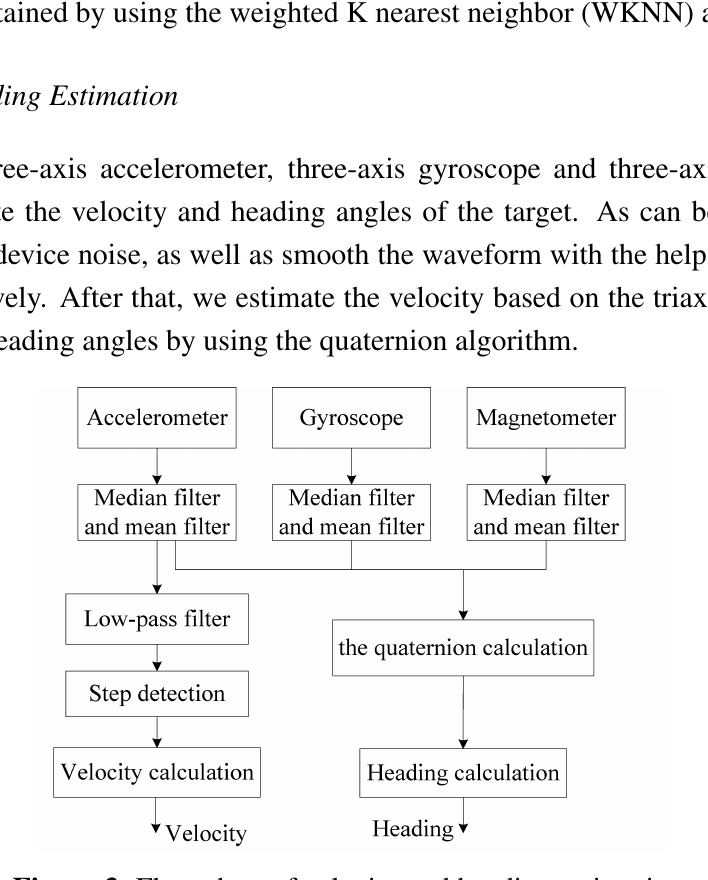
Figure 3. Flow chart of velocity and heading